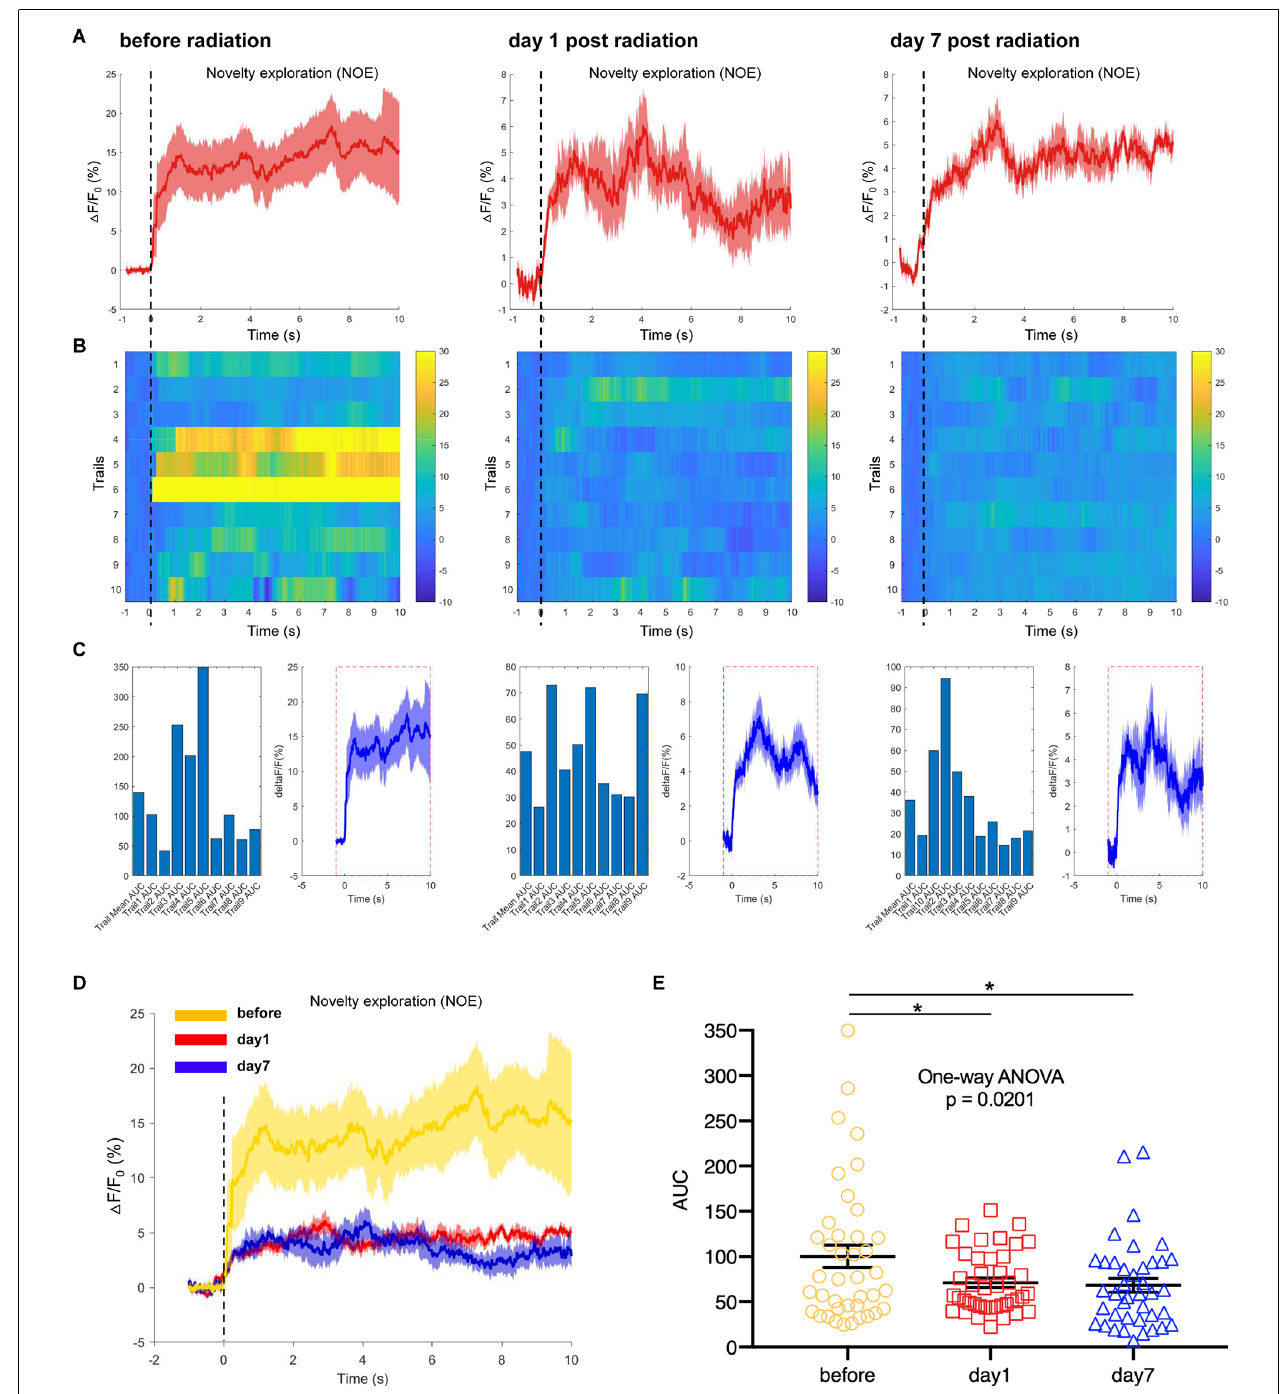
FIGURE 7 | EMP radiation inhibits neuron activities in the hippocampal CA1 area when mice were contacting a novelty during novel object exploration (NOE, n = 3 mice). (A) Plot of calcium amplitude (cid:52) F/F 0 (%) of hippocampal CA1 area, before radiation and on day 1 and day 7 after radiation. The red line is the mean of different trials from a single mouse, and the shaded part represents the standard error. (B) Color-coded intensity of calcium transients from different trials, corresponding to each signal presented in (A) . (C) The area under the curve (AUC) between cue onset (0 s) and subsequent 10 s from different trials as shown in (B) . (D) The combined line diagram of calcium amplitude (cid:52) F/F 0 (%) in CA1 neurons as shown in (A) . (E) Plot of AUC in multiple trials from three biological replicates before and different time points after EMP exposure. 0 s for (cid:52) F/F 0 , marked by dotted lines, indicated that mice were exploring a novelty (NOE). The data in (A–E) are presented as mean ± SEM. One-way ANOVA followed by Bonferroni’s post-hoc tests were performed to evaluate the differences between multiple groups in (E) . * p < 0.05.